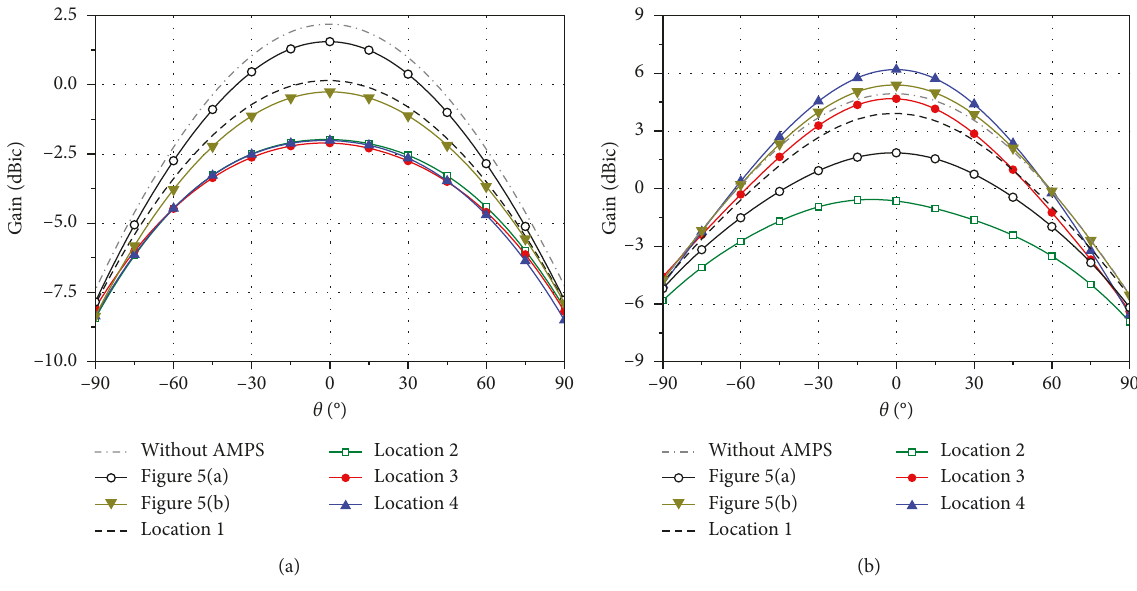
Figure 6: Radiation patterns for different locations of D-APMS. (a) 1.207GHz. (b) 1.561GHz.